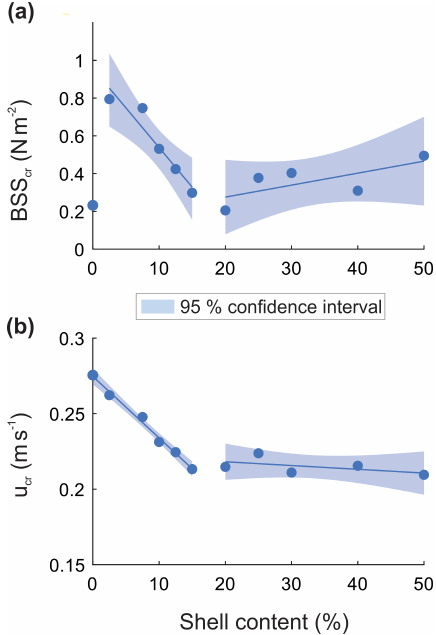
Figure 6. (a) Near-bed streamwise flow and (b) vertical flow at the onset of sediment transport for flat beds (ACC flow experiment). Note that the overbars denote that the x axes are time-averaged, over a 10min period, which encompasses the 5min prior to and following the incipient motion, for the four selected experimental runs.